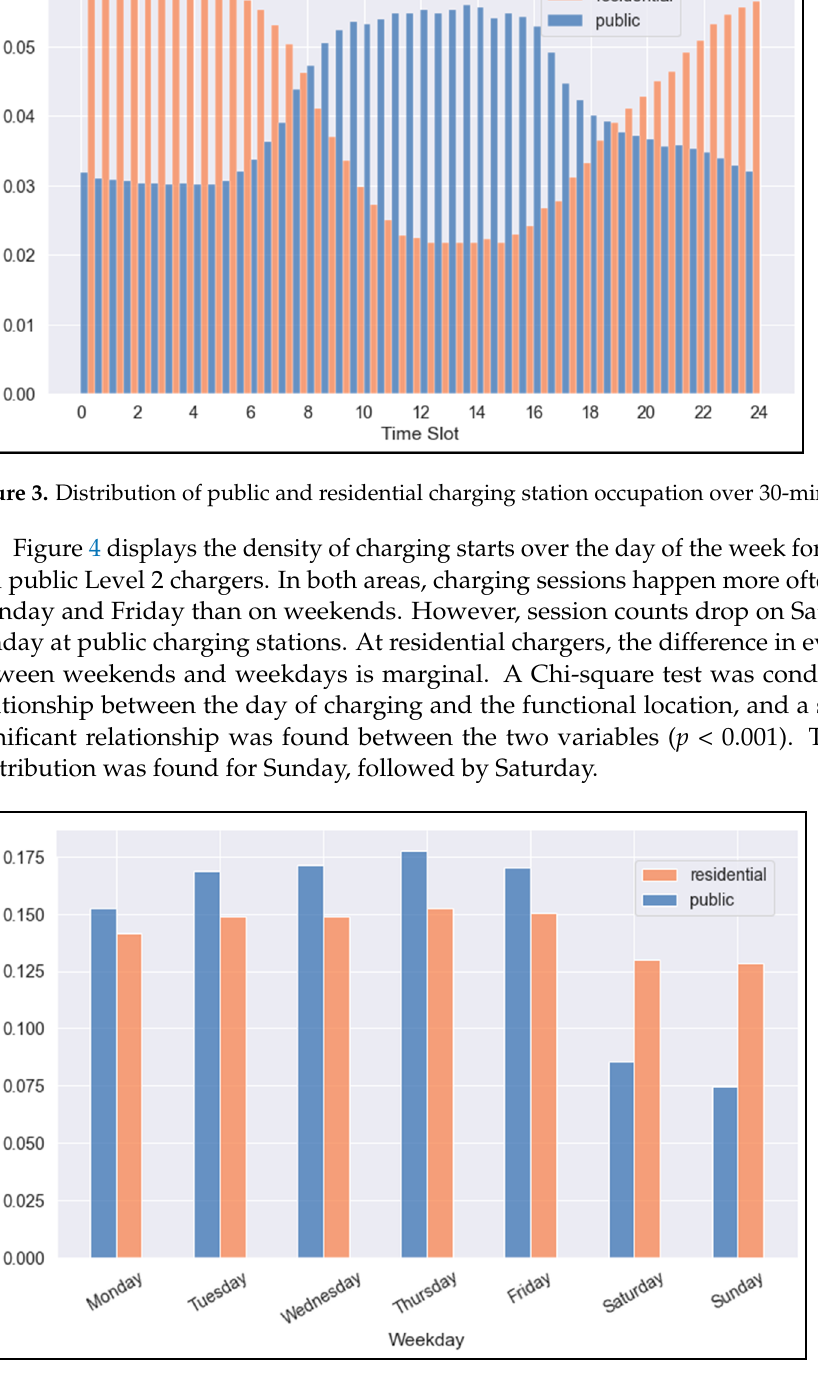
Figure 4. Distribution of public and residential charging event counts over day of the week.